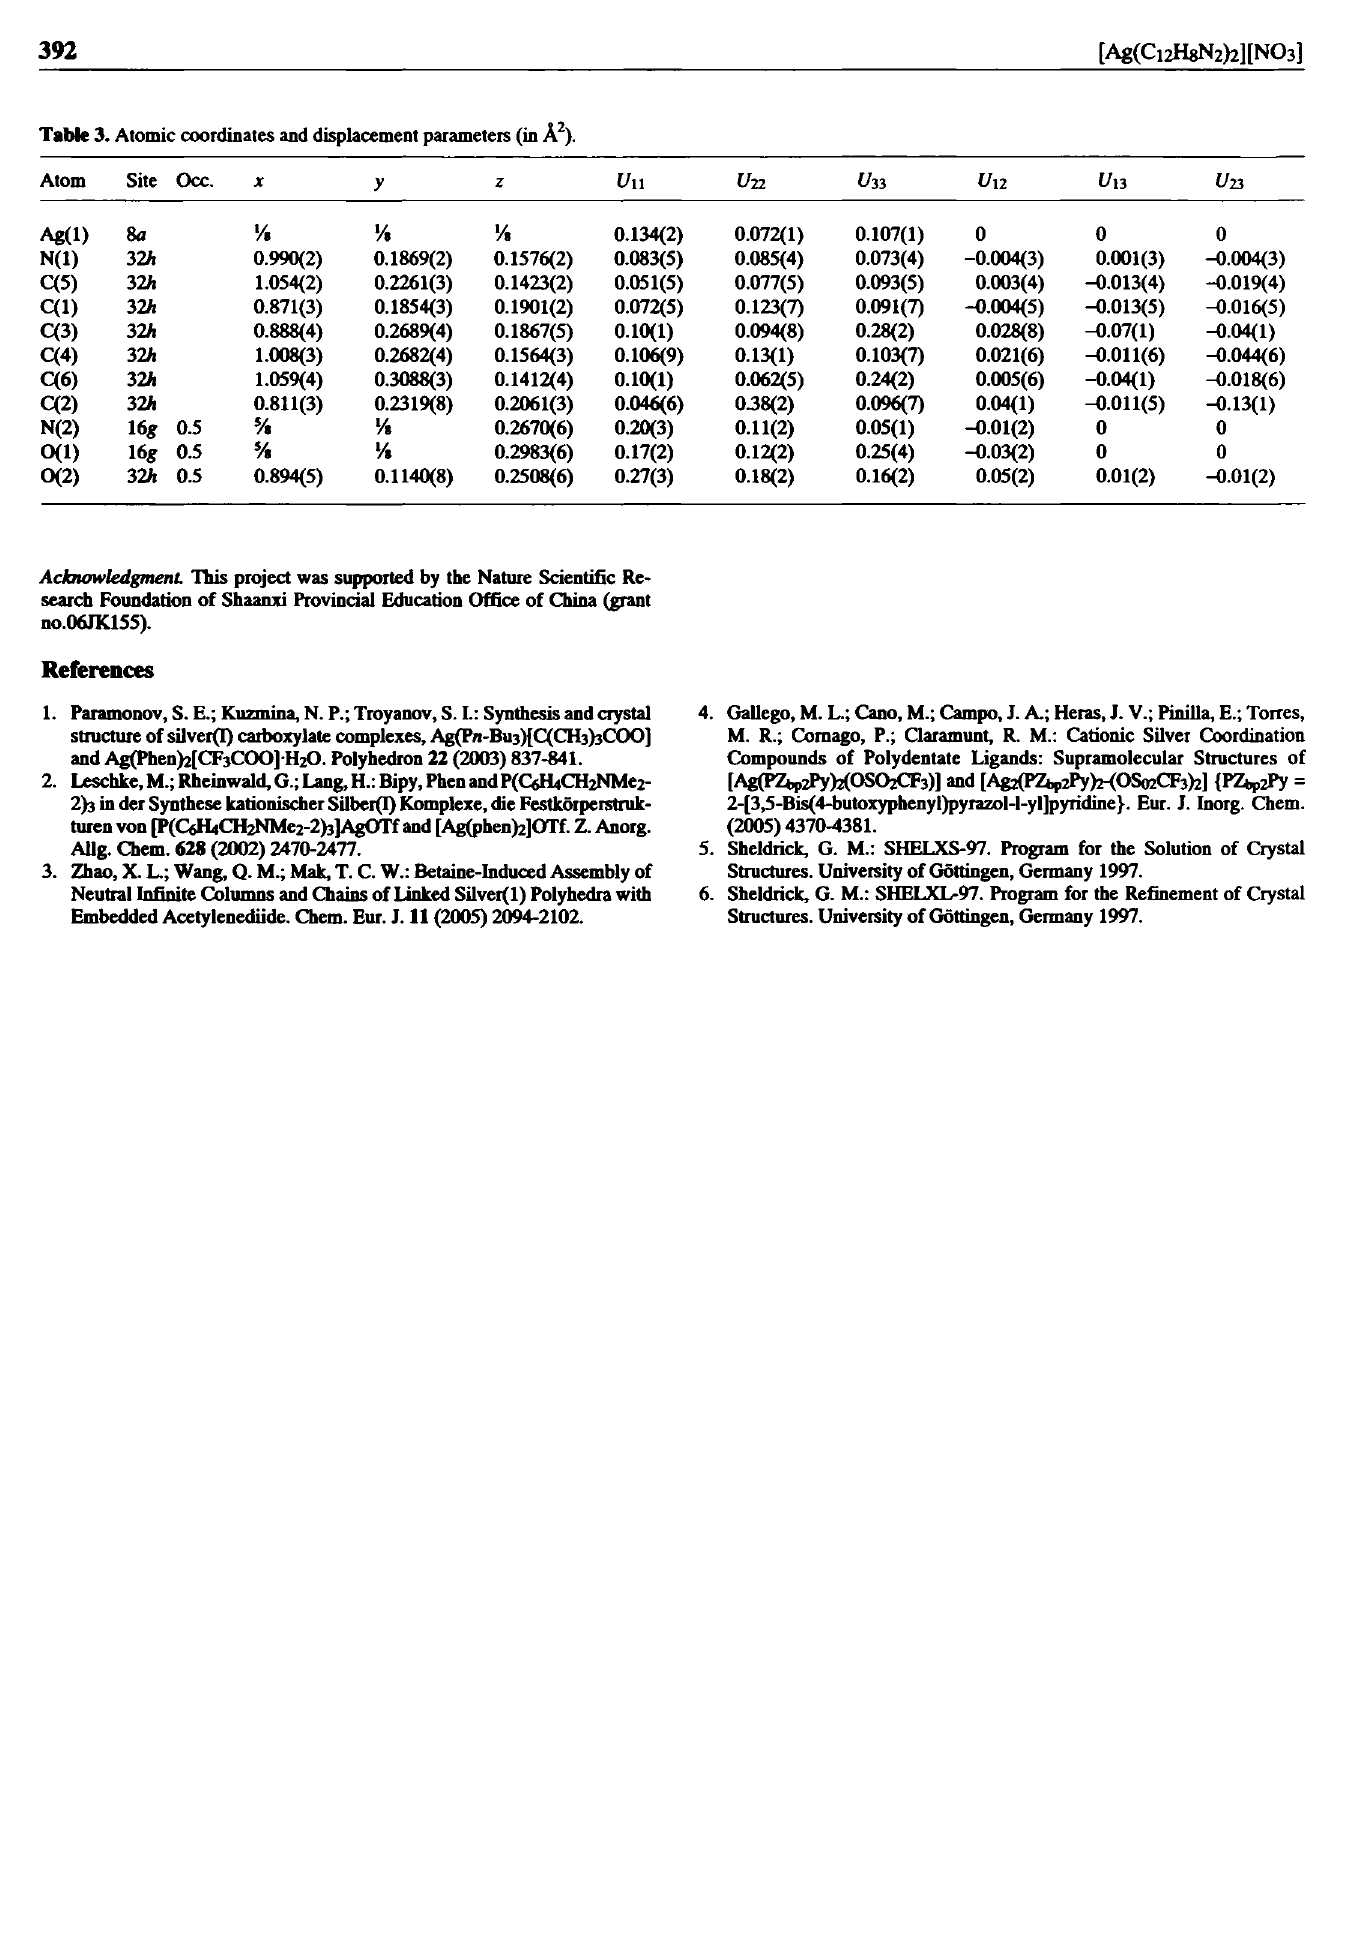
Table 3. Atomic coordinates and displacement parameters (in A 2